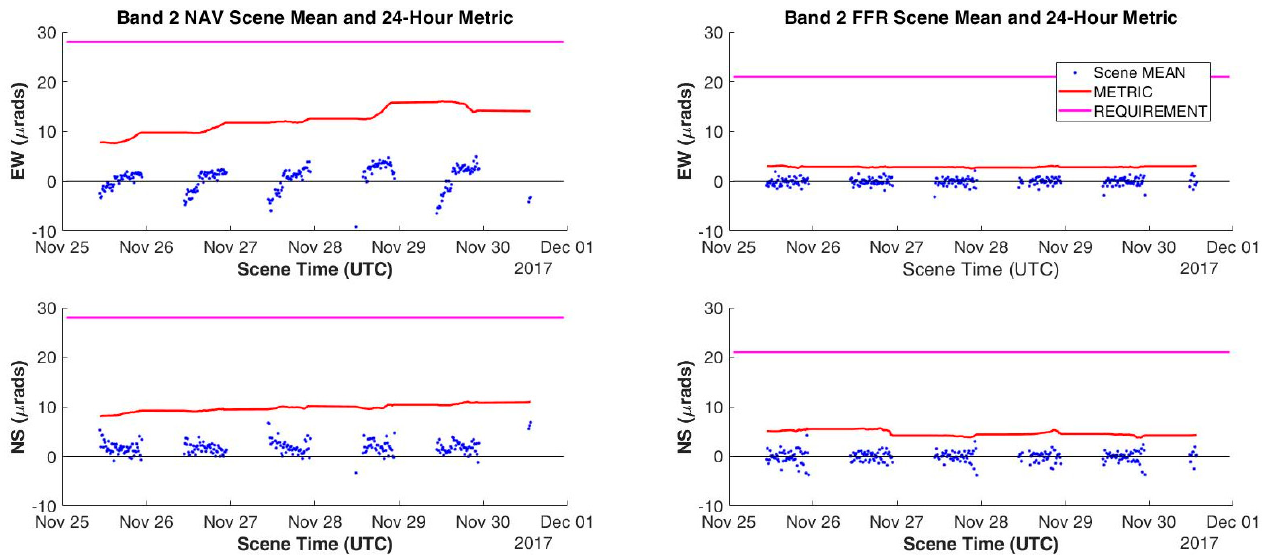
Figure 14. Navigation (NAV) and Frame-to-Frame Registration (FFR) performance metrics for band 2 full disk scenes demonstrate compliance with respect to their respective INR specifications. The metric is calculated as the absolute value of the mean error plus three times the standard deviation computed over a 24-h sliding window. Mean NAV and FFR errors are also aggregated by scene and plotted